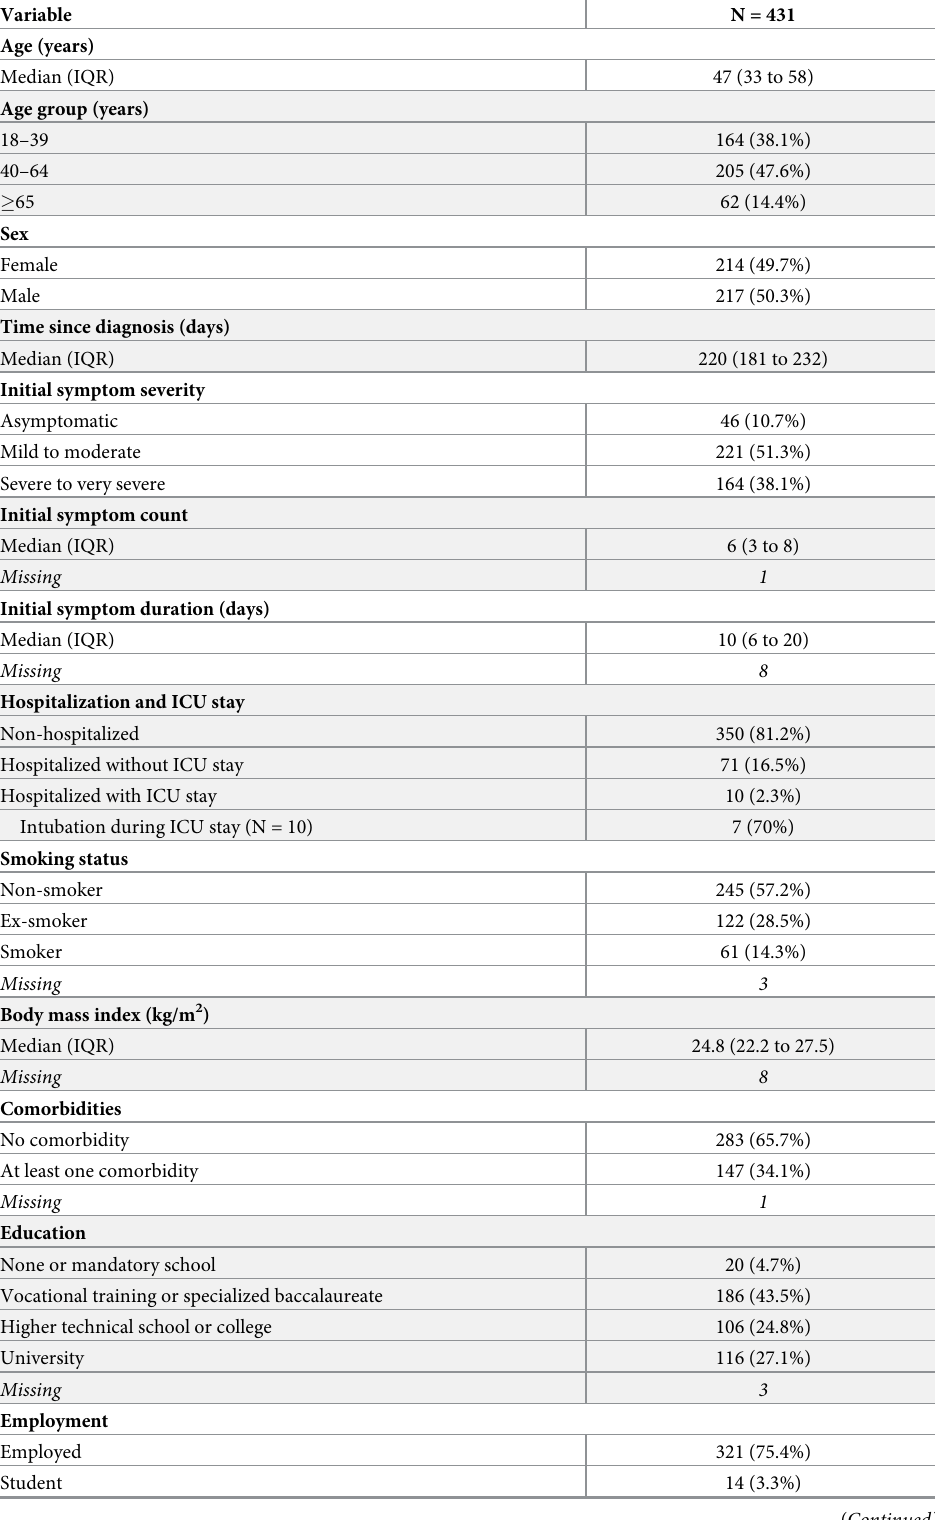
Table 1. Characteristics of study participants enrolled in the Zurich SARS-CoV-2 cohort